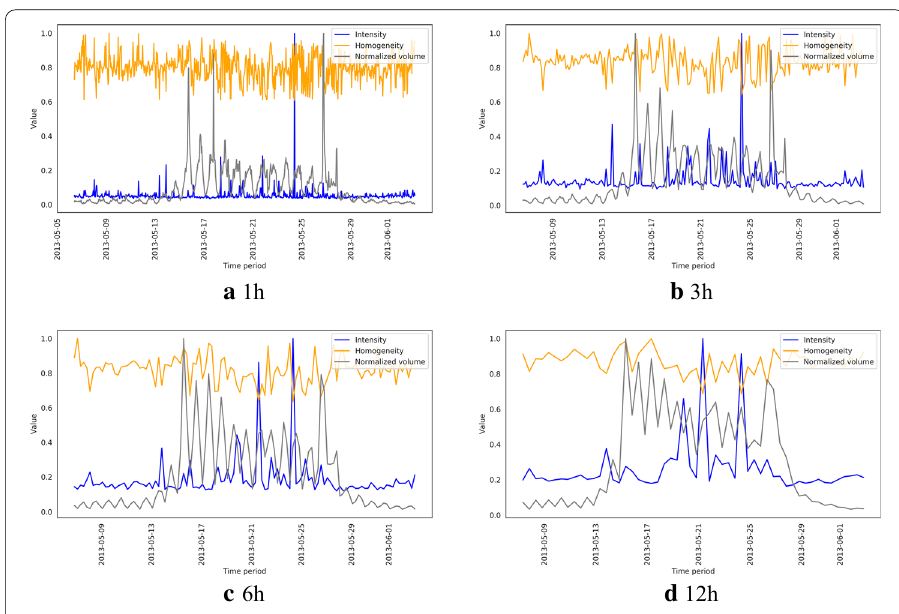
Fig. 27 Different sizes of time windows for the Cannes2013 data set